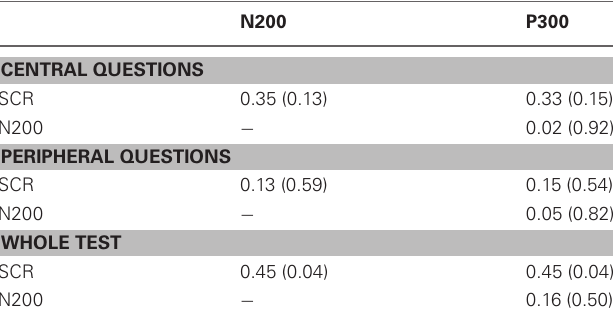
Table 2 | Intercorrelations between the response differences of all physiological measures for central and peripheral mock crime details as well as for the whole